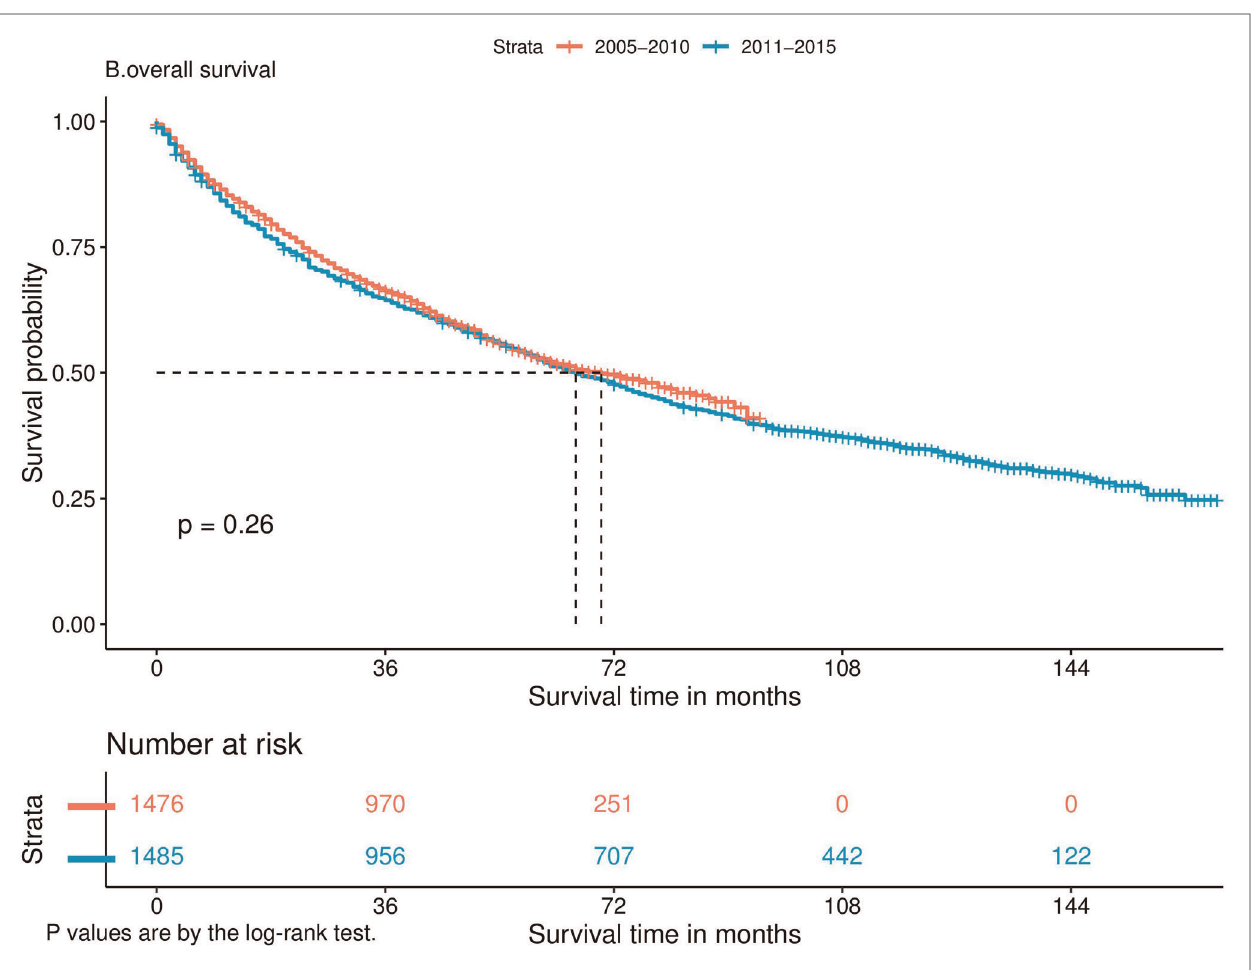
FIGURE 8 | Kaplan-Meier